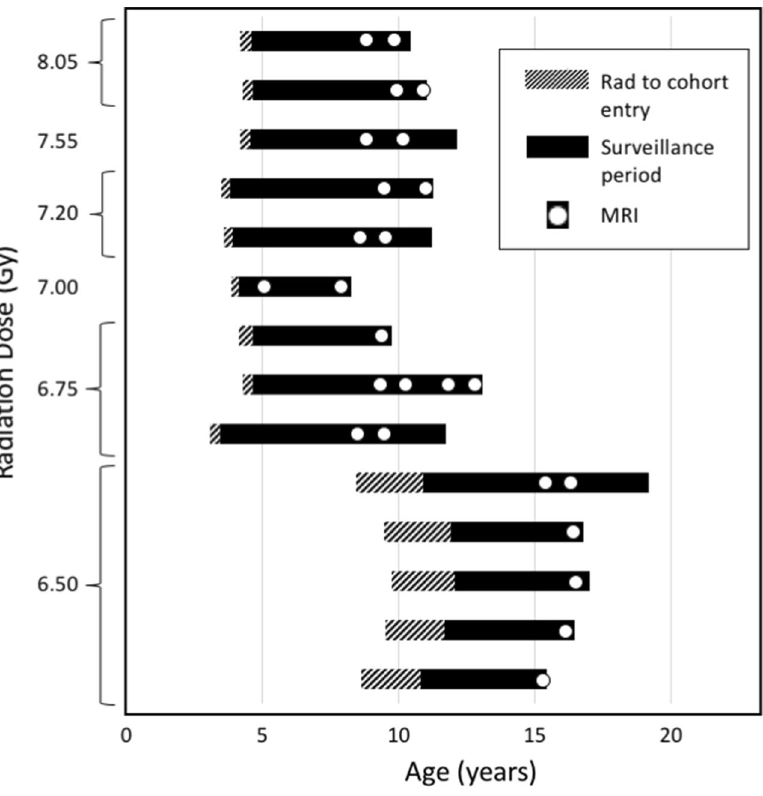
Figure 1. Timeline illustrating the time between radiation exposure and entry into the study, as well as the timing and number of MRI scans for each